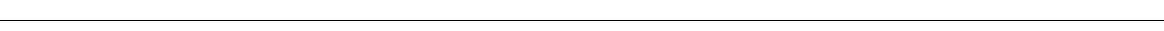
Fig. 1 Dissemination of melanoma cells as function of tumour thickness. a Yellow function: estimated cumulative probability of dissemination as a function of tumour thickness (Turnbull) ( n = 1027 patients). Blue line: Standard log-logistic distribution incorporating a fraction of patients without long-term dissemination (95% CI: blue dashed lines). Upper black dashed line: only 65.2% of melanomas disseminate lymphatically (95% CI: 60.4 – 70.0%). Fifty percent of this value (32.6%) provides the median thickness (0.5 mm, 95% CI: 0.3 – 0.7 mm) of disseminating melanomas (lower black dashed line). b Comparative analysis of histopathological and immuncytological SLN halves. Displayed are representative examples with immunocytological scores of DCCD ≤ 100, 100 < DCCD ≤ 1000 and DCCD > 1000. Samples LN 72 and LN 89 are stained against melan A LN 10, LN 135 and LN 168 against S100. LN 154 shows a highly pigmented melanoma in H&E staining. A close-up of the subcapsular region 3 is shown in the main fi gure; more central or core regions 1 and 2, see Supplementary Fig. 4a for higher magni fi cation. c Evaluation of histopathological fi ndings in corresponding sections of samples with a positive DCCD < 100. d Percentage of DCC-positive patients ( n = 525) with colonisation (DCCD > 100) according to the Turnbull estimate (yellow). The percentage of colonisation (blue curve, 95% CI blue dashed curves) is described by a cumulative exponential distribution function (median 10.3 mm; 95% CI: 8.4 – 13.0 mm). e Hazard functions for dissemination (yellow line), and colonisation (blue line) describing the instantaneous risk per unit thickness for an event (dissemination, n = 1027; colonisation, n = 525) for those tumours, for which it has not yet occurred (de novo dissemination/ colonisation). f Survival analysis of melanoma patients ( n = 1027) according to T stage (T1: ≤ 1 mm ( n = 83); T2: 1.01 – 2.0 mm ( n = 496); T3: 2.01 – 4.0 mm ( n = 315); T4: > 4 mm thickness ( n = 133); log-rank test, p <